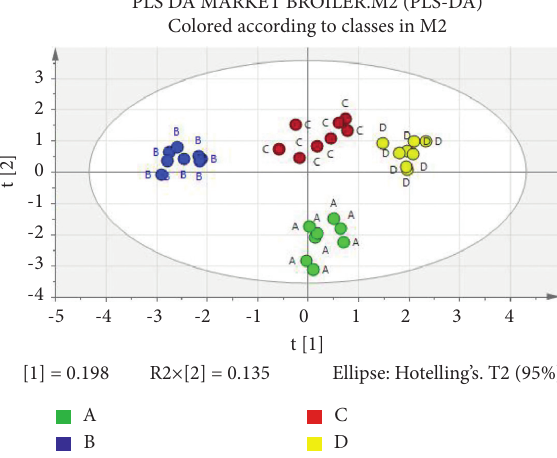
Figure 2: The partial least squares-discriminant analysis (PLS-DA) score plot of control and market samples of broiler chicken. Colored circles are represented by CBC � control broiler chicken (green); MBC 1 � market 1 (blue); MBC 2 � market 2 (maroon); MBC 3 � market 3 (yellow). Table 7: Proximate composition of colored chicken meat obtained from a genuine supplier and three different markets.